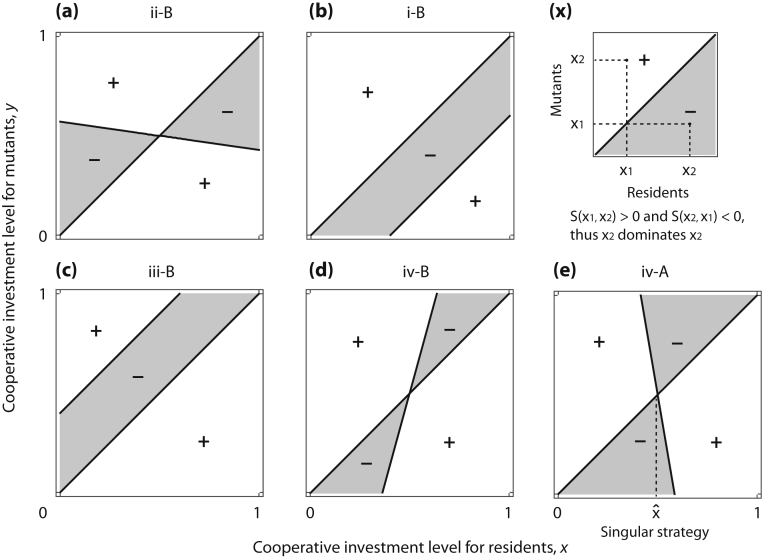
Pairwise invisibility plots (PIPs) for the continuous snowdrift game. Each panel shows a sign plot of invasion fitness S(x,y) in Eq. (11). Due to the linearity of the payoff difference with respect to the strategy frequency, the sign pair (S(x2,x1),S(x1,x2)) can indicate the frequency dynamics between the strategies with x1 and x2. Panel (x) exemplifies the case of (S(x2,x1),S(x1,x2)) = (+,−) which leads to a unilateral evolution: x2 dominates x1. The five sign plots are representative corresponding to the five cases of adaptive dynamics in the continuous snowdrift game: (a), (b), (c), (d), and (e) are for (ii-B), (i-B), (iii-B), (iv-B), and (iv-A), respectively. Parameters: c1 = 4.6, c2 = −1; (d1,d2) = (0.3, −0.3) for (a), (0.7, −0.3) for (b), (0.3, −0.7) for (c), (0.7, −0.7) for (d), and (1.7, −1.7) for (e).